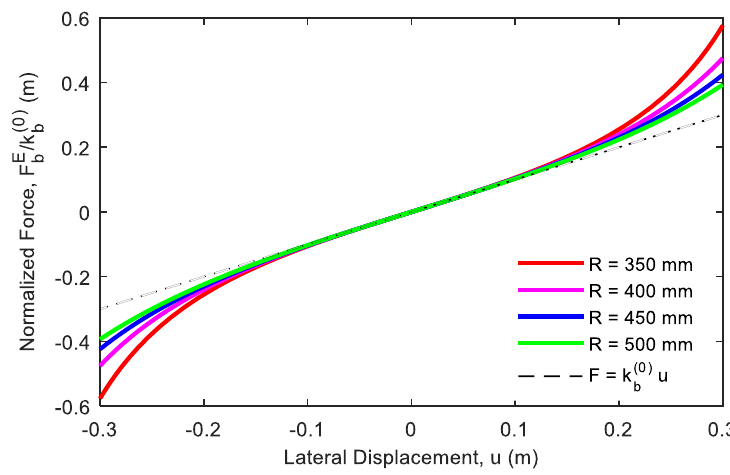
Figure 4. Elastic response of the isolator with compressed air piston.